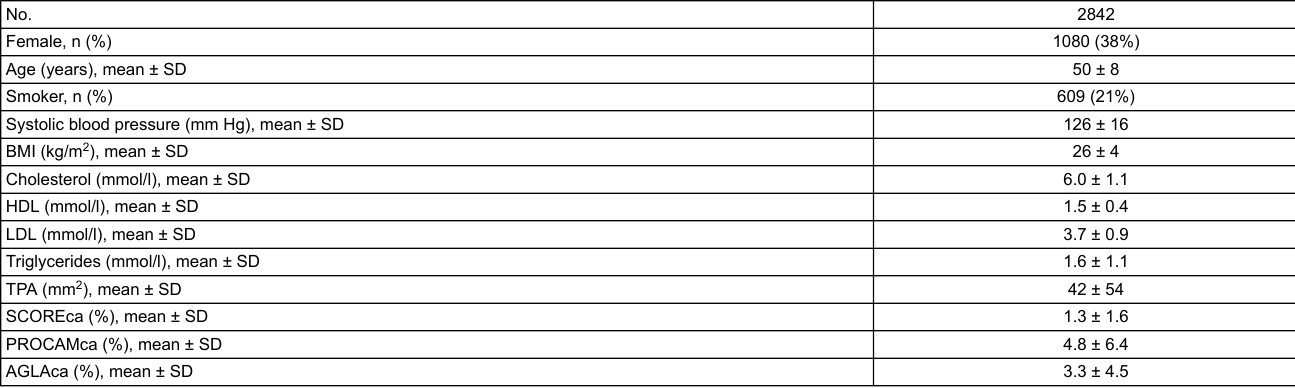
Table 1: Baseline characteristics, results from risk scores and imaging. No.